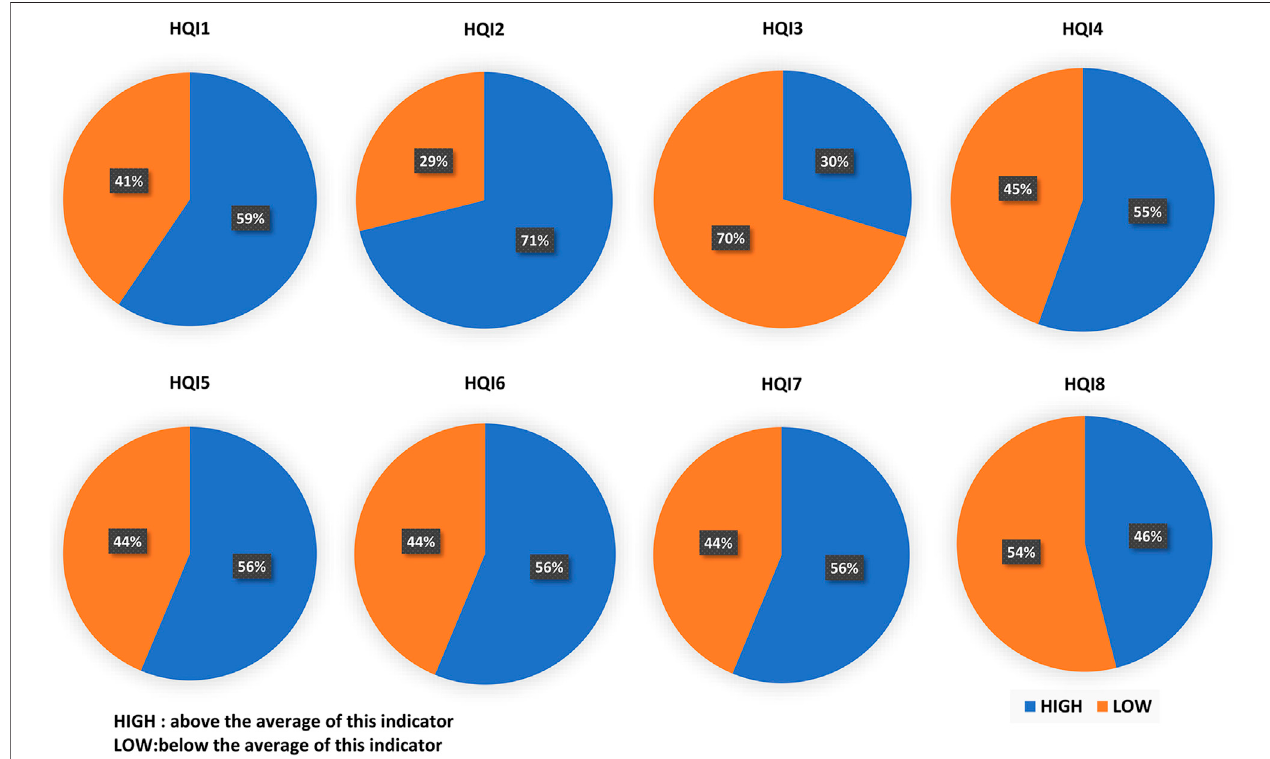
FIGURE 4 | Proportion of eight high-quality amino acid indices (HQI) on the drug-binding sites. The eight indices from HQI1 to HQI8 denote electric charge properties, hydrophobicity, beta-strand propensities, alpha helix and turn propensities, volume, transmembrane residue propensities, amino acid composition, and relative partition energies, respectively. HIGH (blue color) denoted above the average of this indicator, while LOW (orange color) denoted below the average of this